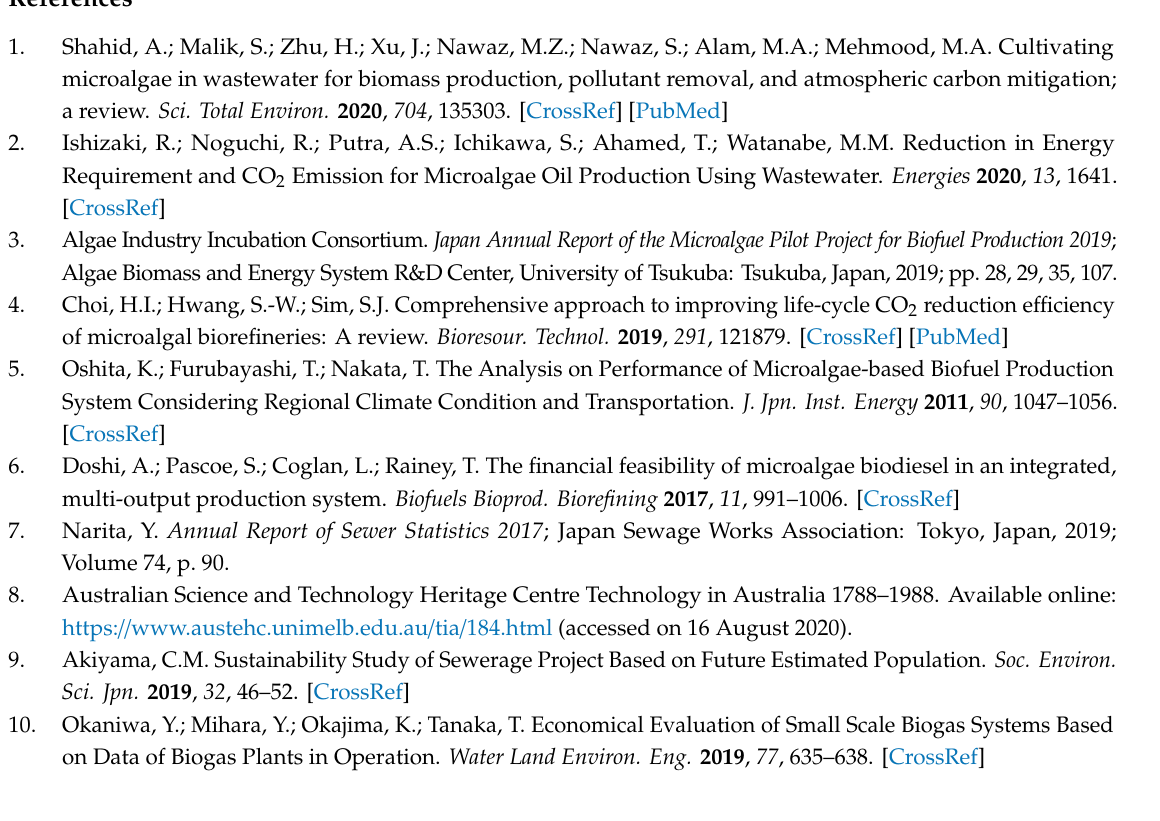
Table 3. Cost calculation parameters for each scenario.